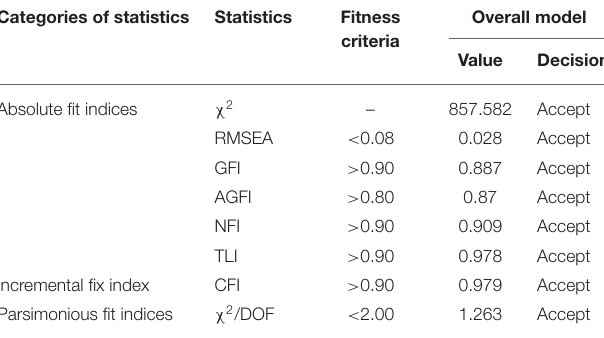
TABLE 5 | Fit indexes for the structural